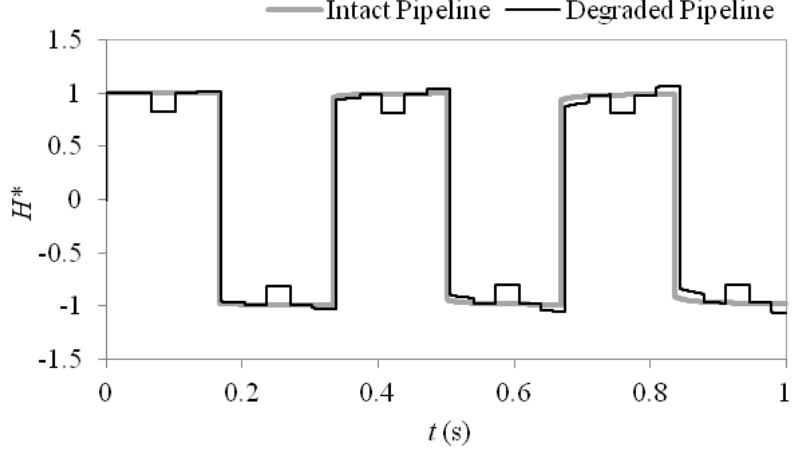
Figure 2. Comparison between an intact MSCL pipeline and a pipeline which has lost lining over a length of L * = T